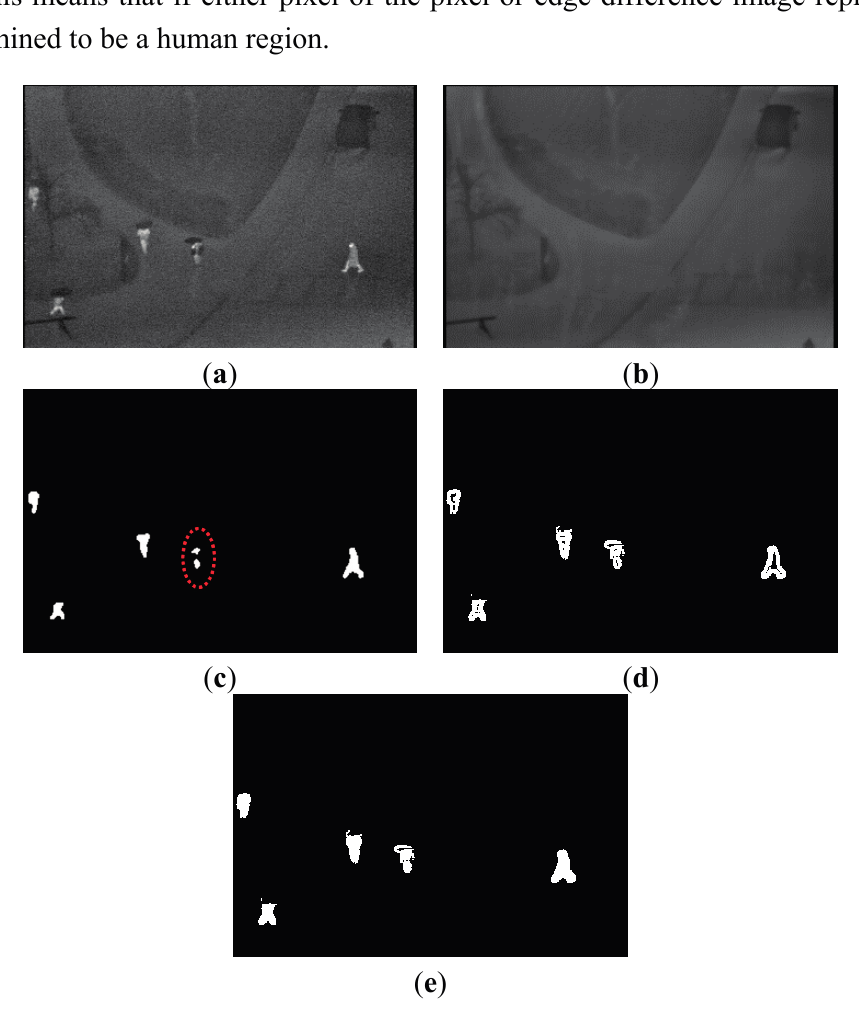
Figure 6. Example of the fusion of two difference images: ( a ) input image; ( b ) background image; ( c ) pixel difference image; ( d ) edge difference image; and ( e ) fusion of the pixel and edge difference